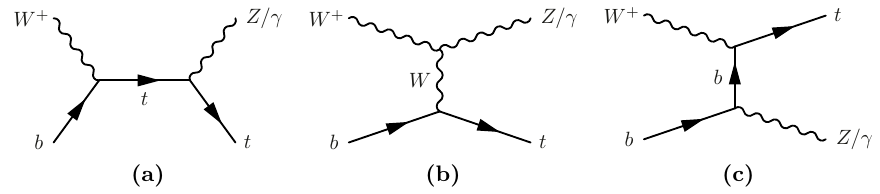
Figure 5. SM diagrams for the bW